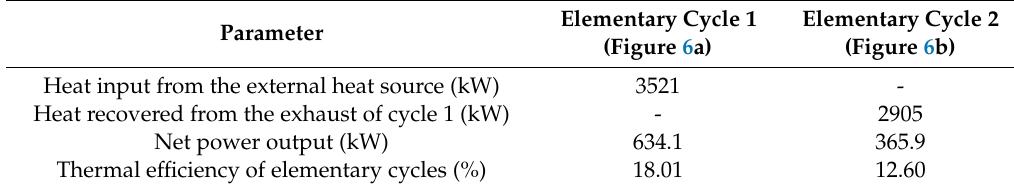
Table 7. Thermal e ffi ciency of the two elementary thermodynamic cycles that compose the dual Table 7. Thermal efficiency of the two elementary thermodynamic cycles that compose the dual recuperated s-CO 2 power cycle. recuperated s-CO 2 power cycle.